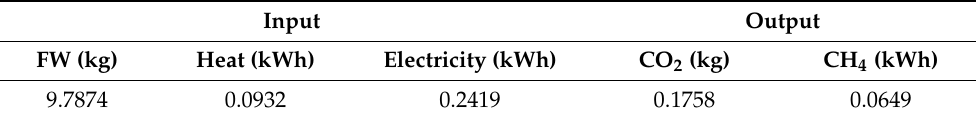
Table 1. Input–output balance for food waste (FW)-based green methane production in China.